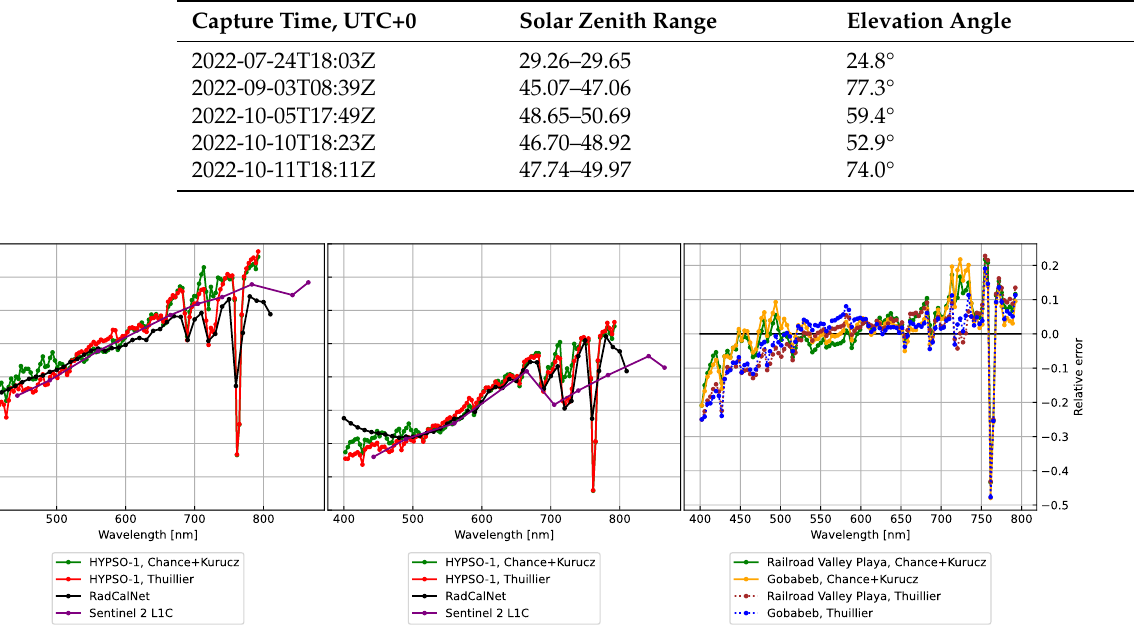
Figure 12. ToA reflectance spectral comparison of HYPSO-1 and RadCalNet calibration site Railroad Valley Playa. The date of each capture is stated in the top left. The HYPSO-1 ToA reflectance was calculated using the Chance+Kurucz solar spectrum and the Thuillier solar spectrum. See table 7 for information on the geometry. atmospheric scattering. An inconsistency is also observed when comparing the HYPSO-1